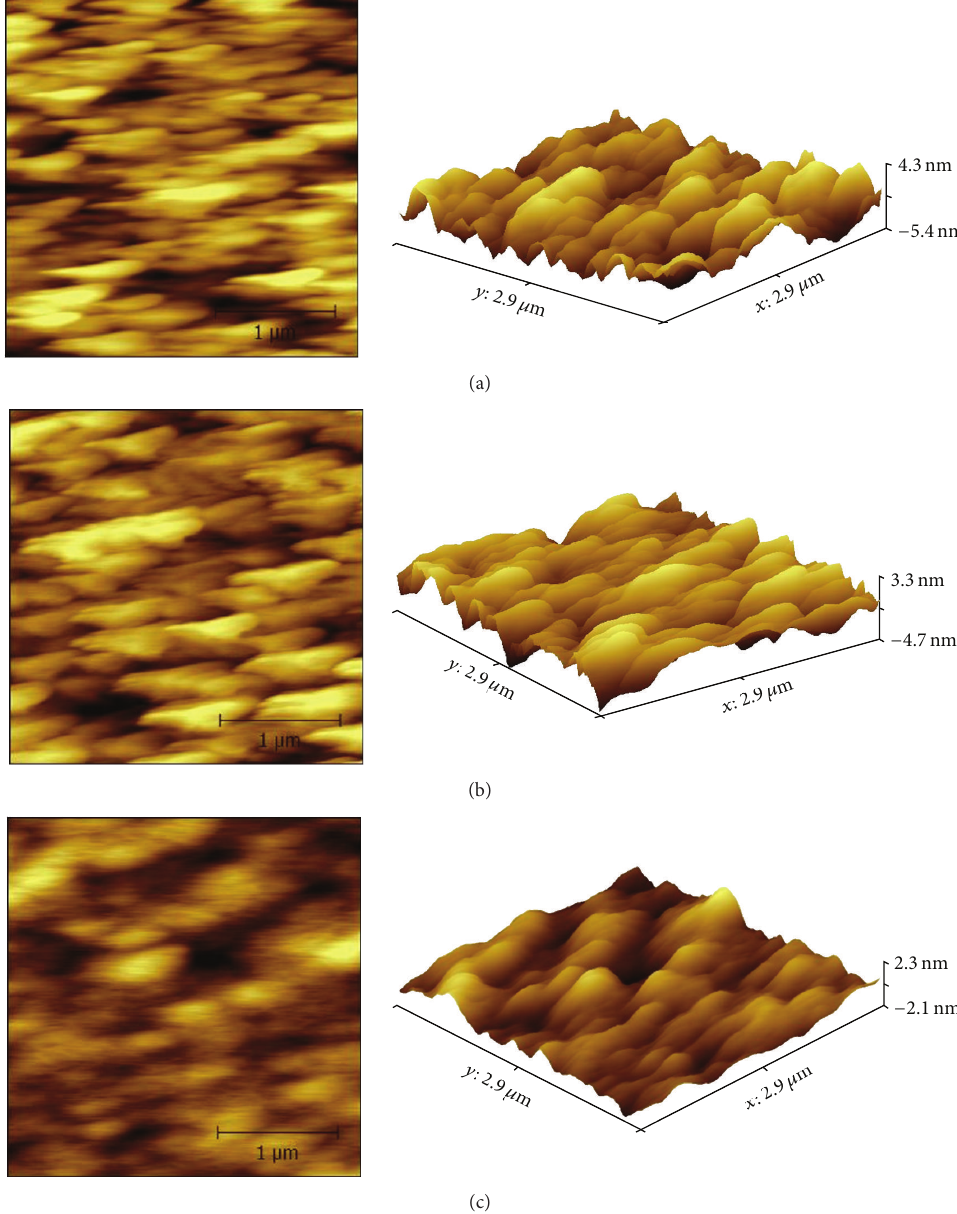
Figure 5: Surface morphologies of (a) ITO/PEDOT:PSS, (b) ITO/ZnO (annealed in air), and (c) ITO/ZnO (annealed in N 2